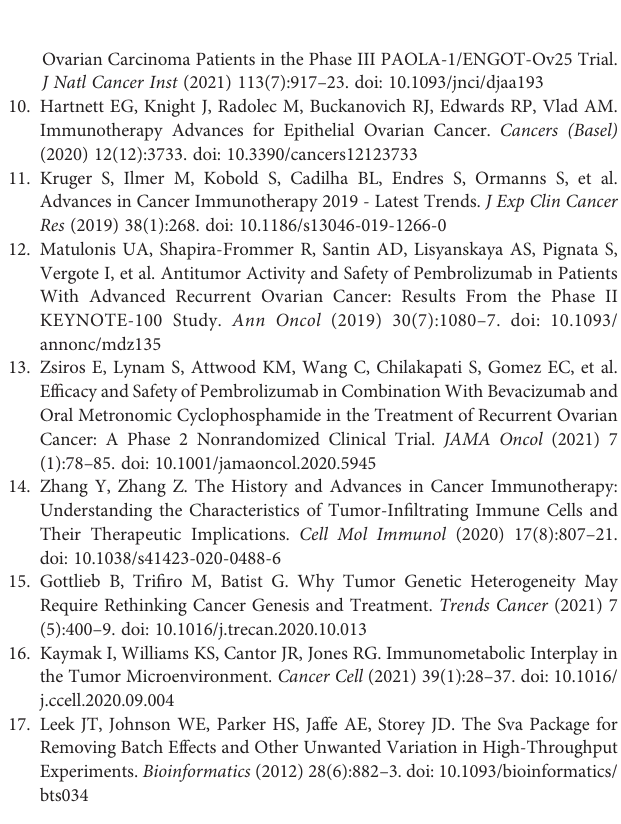
Supplementary Figure 1 | Violin plots of four immune checkpoint genes. Wilcoxon test. ns: not signi fi cant. Supplementary Figure 2 | PCA analyses before and after removing the batch effects. Supplementary File S1 | The immune cell in fi ltrations calculated in the TCGA cohort with CIBERSORT. Supplementary File S2 | Immune and stromal scores calculated with ESTIMATE. Supplementary File S3 | The list of the DEGs and characteristic genes screened with